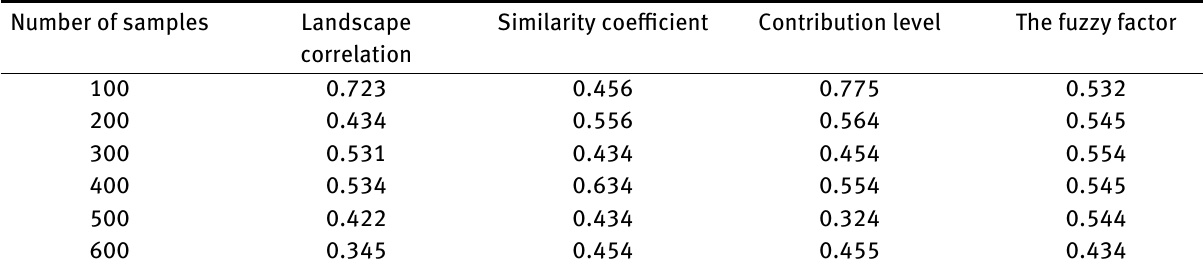
Table 1: Descriptive statistical analysis results